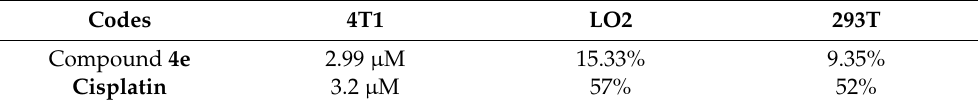
Table 3. Determination of IC 50 ( μ M) values for compound 4e and cisplatin against 4T1 cell line; cytotoxic effect of compound 4e and cisplatin (% inhibition) against LO2 and 293T cell lines at 50 μ M.